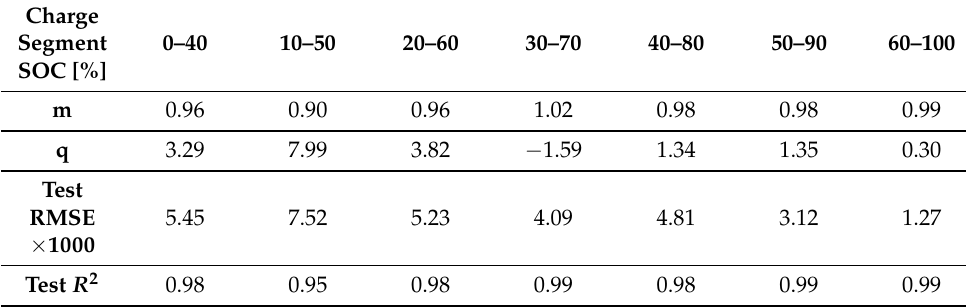
Table 5. Analysis #3: Best neural network regression statistics.